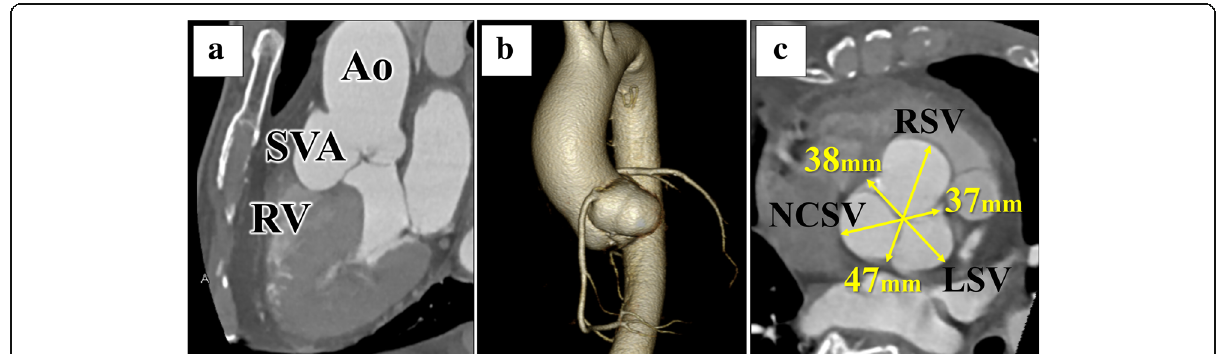
Fig. 1 Preoperative computed tomography. a , b An unruptured right SVA protrudes into the right ventricular outflow tract. c RSV, 47 mm; LSV, 38 mm; NCSV, 37 mm. Ao: aorta; SVA, sinus of Valsalva aneurysm: RV, right ventricle; RSV: right sinus of Valsalva; LSV: left sinus of Valsalva; NCSV: non-coronary sinus of Valsalva